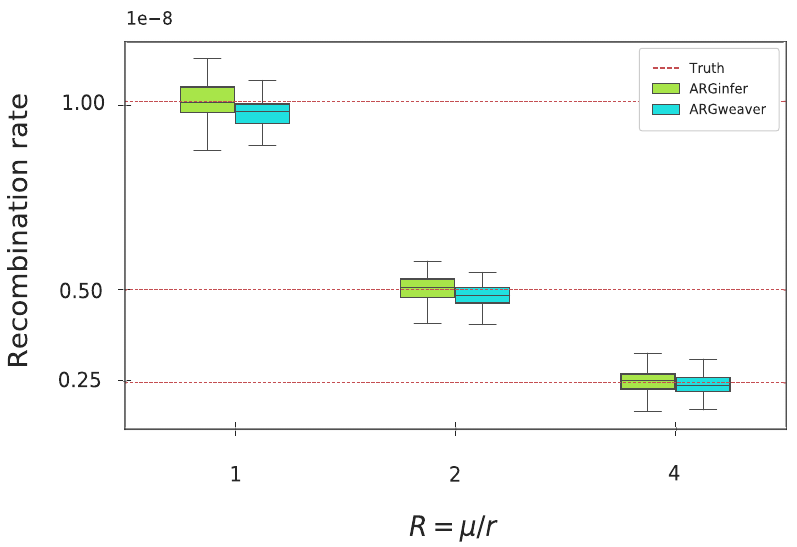
Fig 4. Estimated recombination rates for 150 simulated data sets from ARGinfer and ARGweaver for R = 1, 2, and 4. The red dashed lines (“Truth”) show the mean of the true number of ancestral recombination events divided by the true total branch length. See S1 Table for p -values from testing equality of true and inferred values.